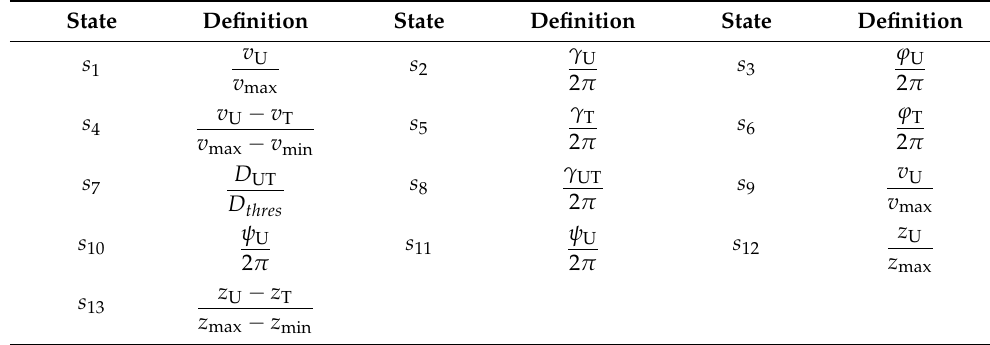
Table 1. The state space for the DQN model.